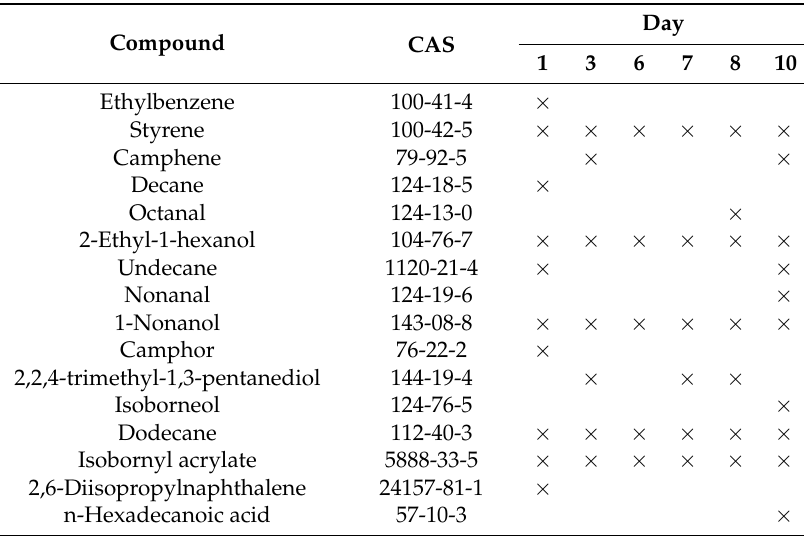
Table 2. Compounds identified in the headspace of Labskin after 15 min headspace sample collection by SPME followed by thermal desorption to GC–MS, in order of increasing retention time. ( × indicates the presence of a compound in a